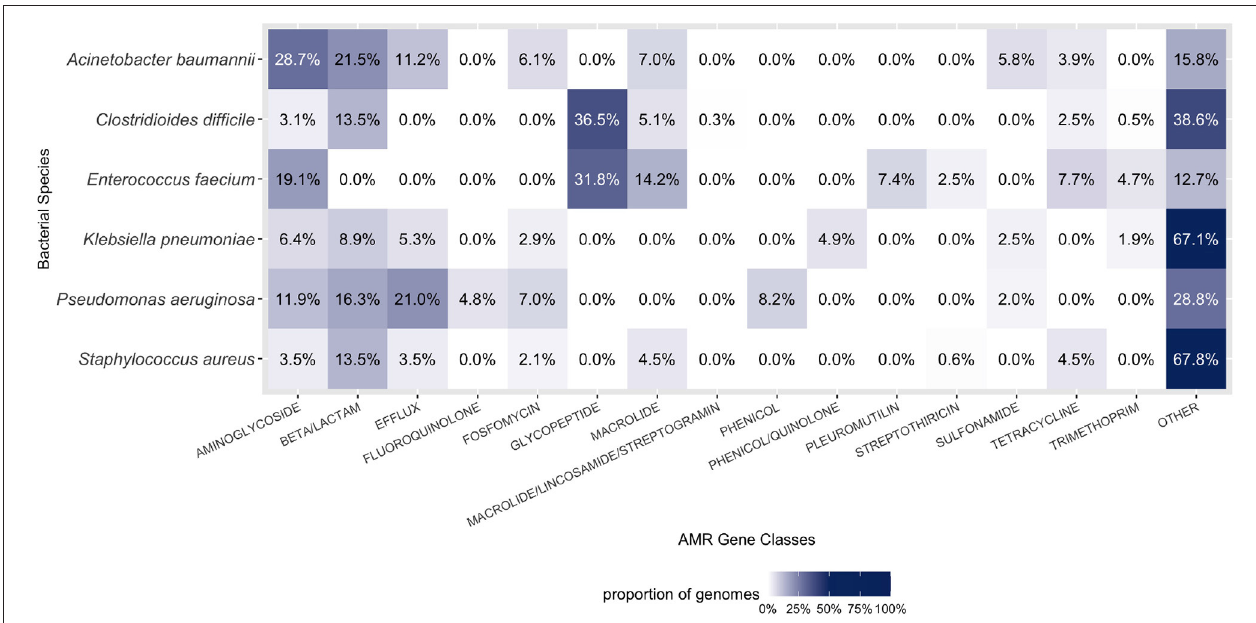
FIGURE 5 | Composition of AMR gene classes by species. A large proportion of each ESKAPE+C pathogen’s genome consists of AMR genes. Only the top six abundant AMR gene classes for each species were considered in the figure above. Percentages were calculated in context of all gene classes, both AMR and